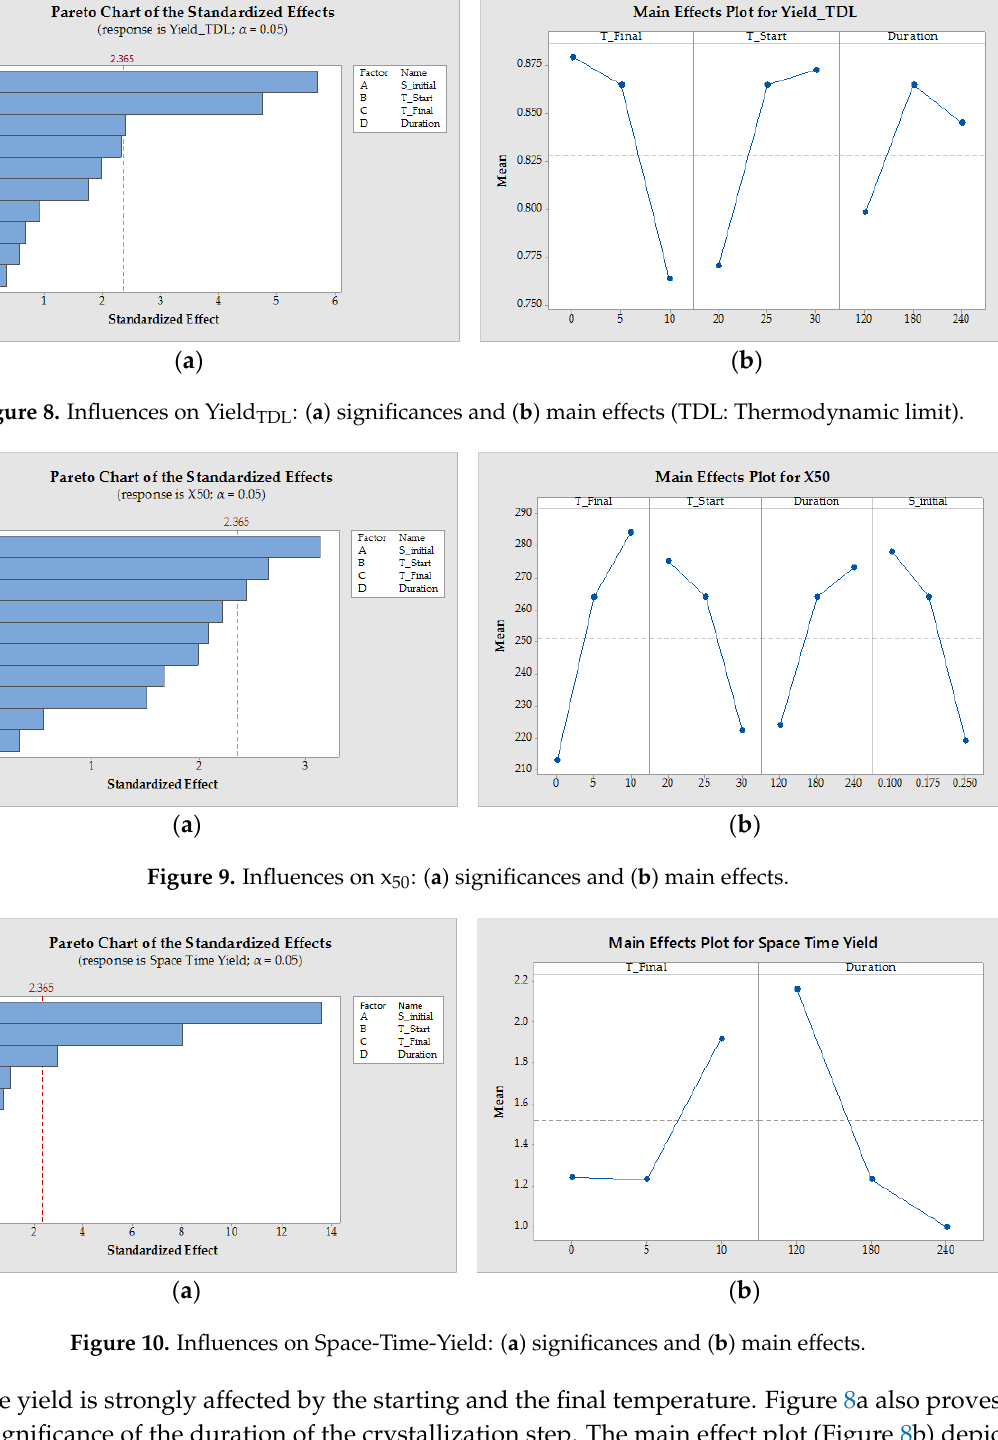
Figure 10. Influences on Space-Time-Yield: ( a ) significances and ( b ) main effects.